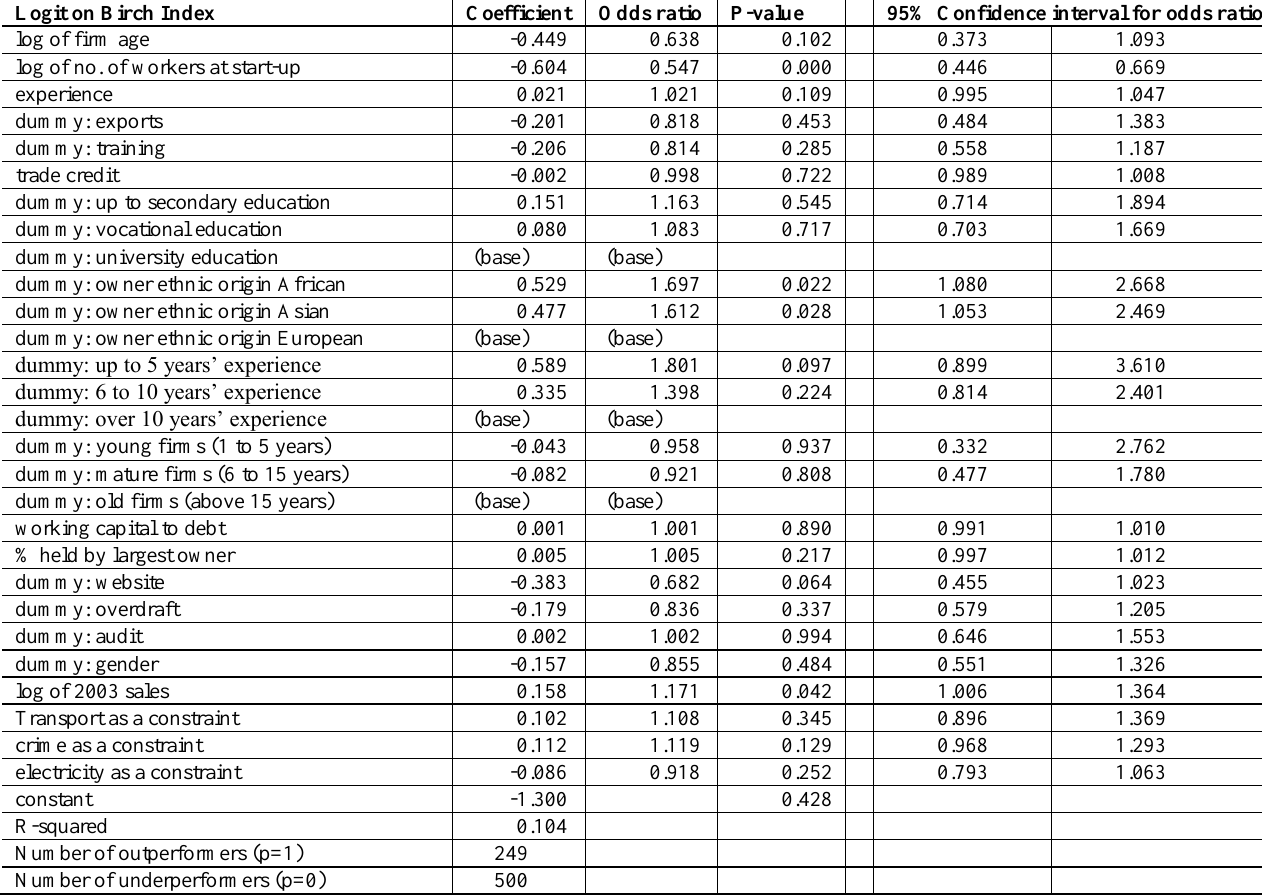
Table 2: Logistic regression results on the characteristics of outperformers and underperformers Logit on Birch